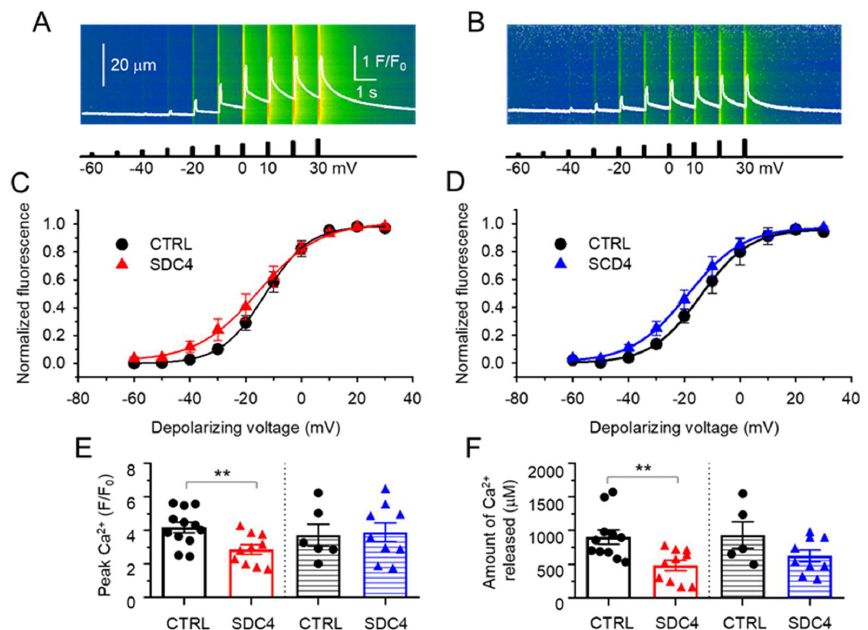
Figure 4. Representative line-scan images of rhod-2 fluorescence normalized to the baseline value F 0 (x) in a CTRL ( A ) and SDC4 ( B ) FDB cell from young mice subjected to successive rectangular depolarizing voltage steps under a whole-cell voltage clamp. The Ca 2+ transients were elicited by 100 ms long progressively increasing membrane depolarizations ranging from − 60 mV to +30 mV, with 10 mV increments every 1 s. The white trace is the temporal profile of the normalized fluorescence obtained by averaging 50 lines in the spatial domain normalized to average resting F 0 (x) values. Voltage dependence of the changes in [Ca 2+ ] i in young ( C ) and in aged ( D ) mice. The normalized F/F 0 values were fitted with a Boltzmann function (Equation (1) in the Methods section) and then normalized to the obtained maximum for a given fibre, and, lastly, averaged over the fibres in each group. The continuous lines represent the best fit of the Boltzmann function to the average values with the following parameters: V 50 = − 13.04 and − 13.66 mV, k = 7.91 and 11.23 for four young CTRL and four SDC4 mice, respectively, and V 50 = − 13.24 and − 18.77 mV, k = 8.80 and 10.02 mV for four aged CTRL and five SDC4 mice, respectively. Pooled data for peak F/F 0 values ( E ) and amount of Ca 2+ released ( F ) obtained from single maximal depolarizing pulses (+30 mV). Empty columns represent data from young (12 fibres from 3 male and 1 female CTRL mice and 12 fibres from 3 male and 2 female SDC4 mice), dotted columns show data from aged (10 fibres from 4 male CTRL mice and 6 fibres from 5 male SDC4 mice) animals, respectively. ** shows a significant difference from the age-matched CTRL group at p <